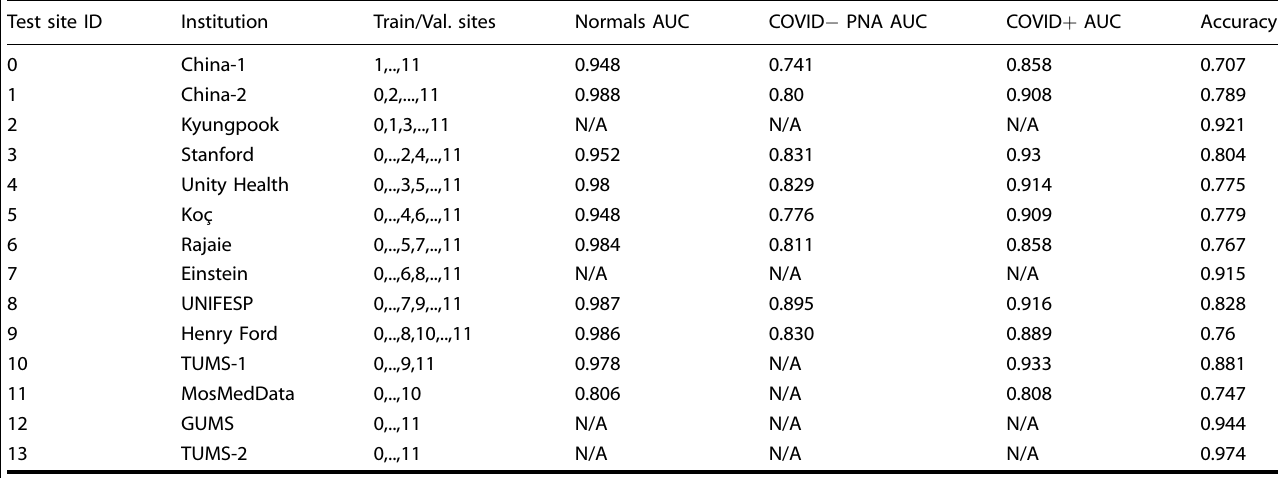
Table 1. Performance on all test